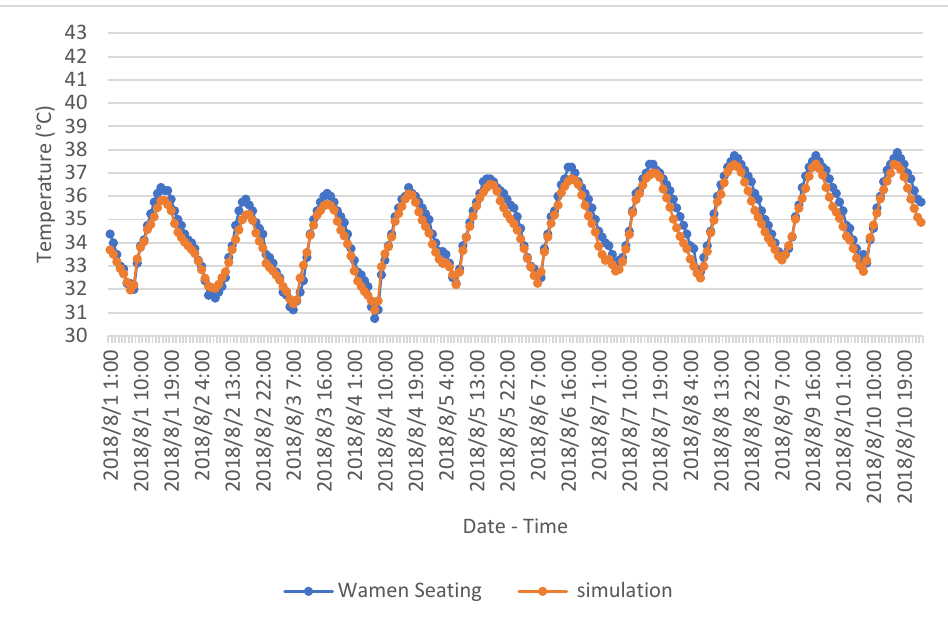
Figure 3. Temperature calibration of the simulation results for bedroom 1 in the traditional house in Riyadh City.